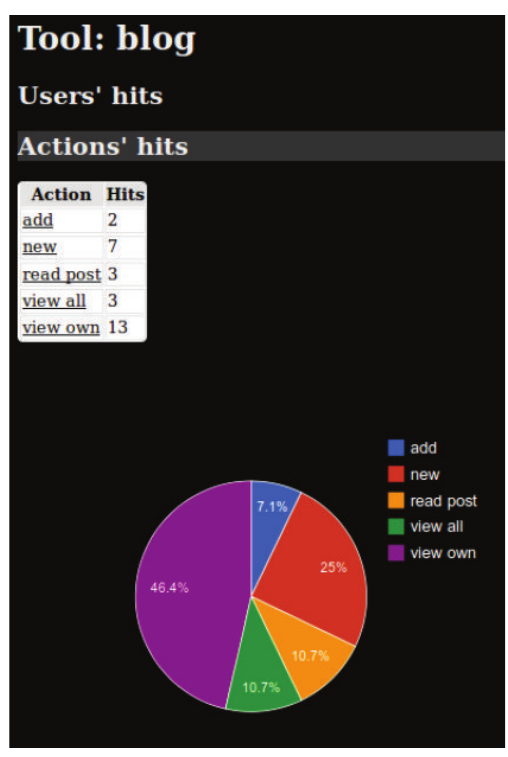
Figure 15: Reporting the actions usage for the “Groups”